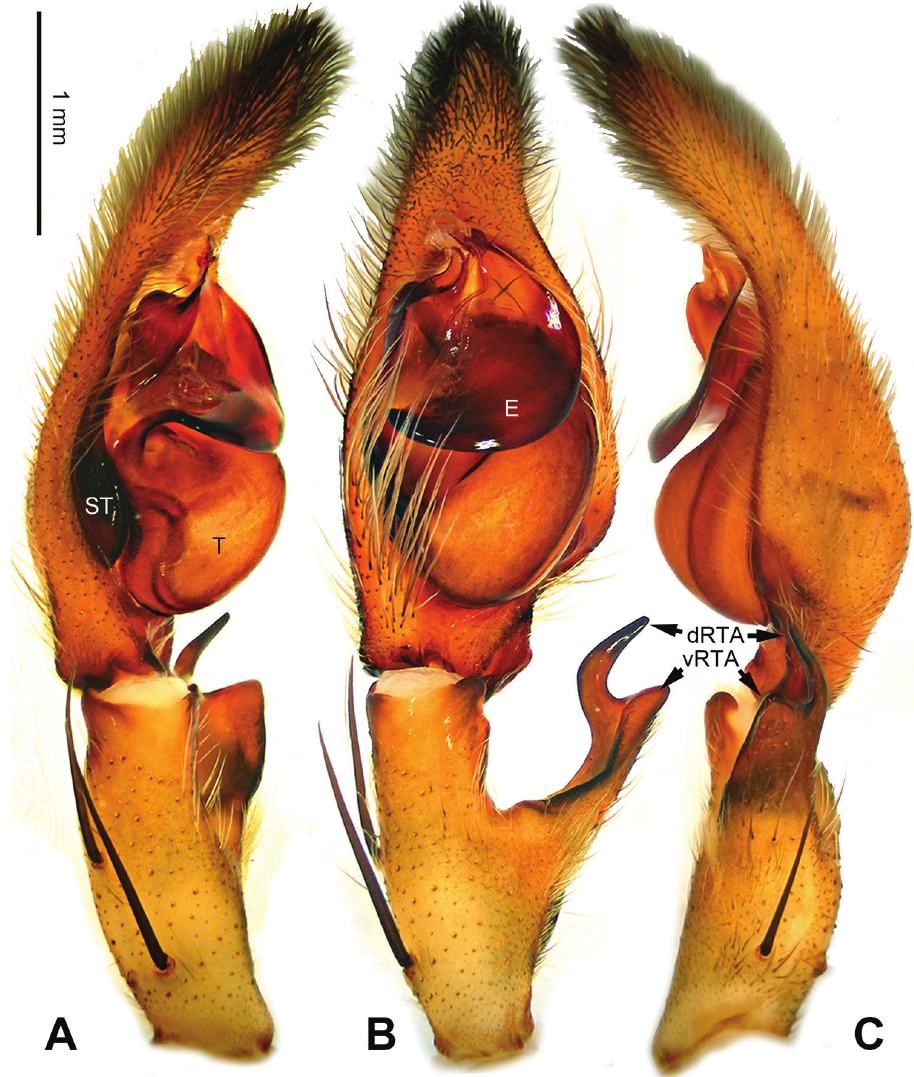
Figure 8. Pseudopoda daxing Zhao & Li, sp. n., left palp of male holotype. A Prolateral view B Ventral view C Retrolateral view. Scale bar equal for A, B, C